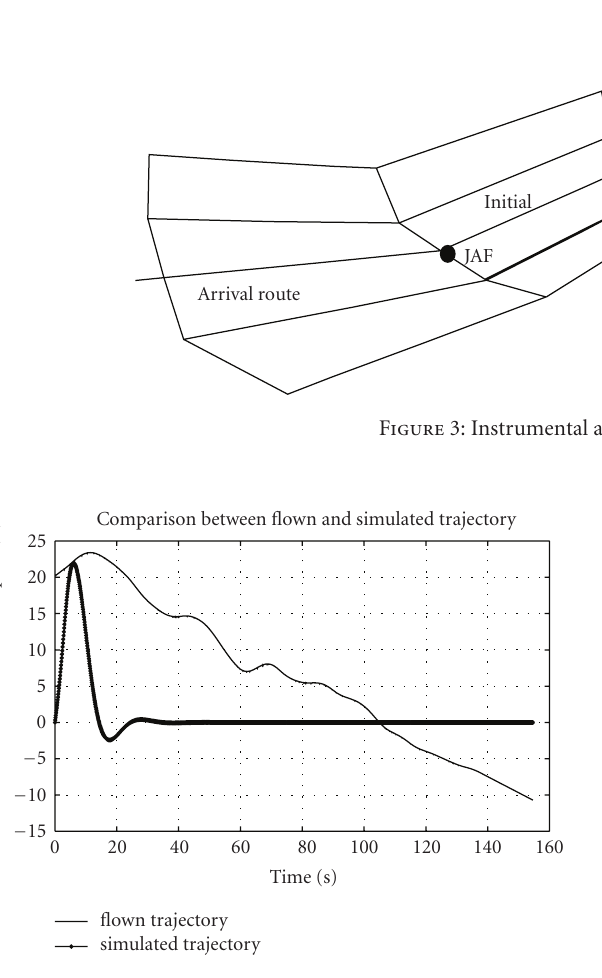
Figure 4: Numerical and experimental positioning error in a GBAS